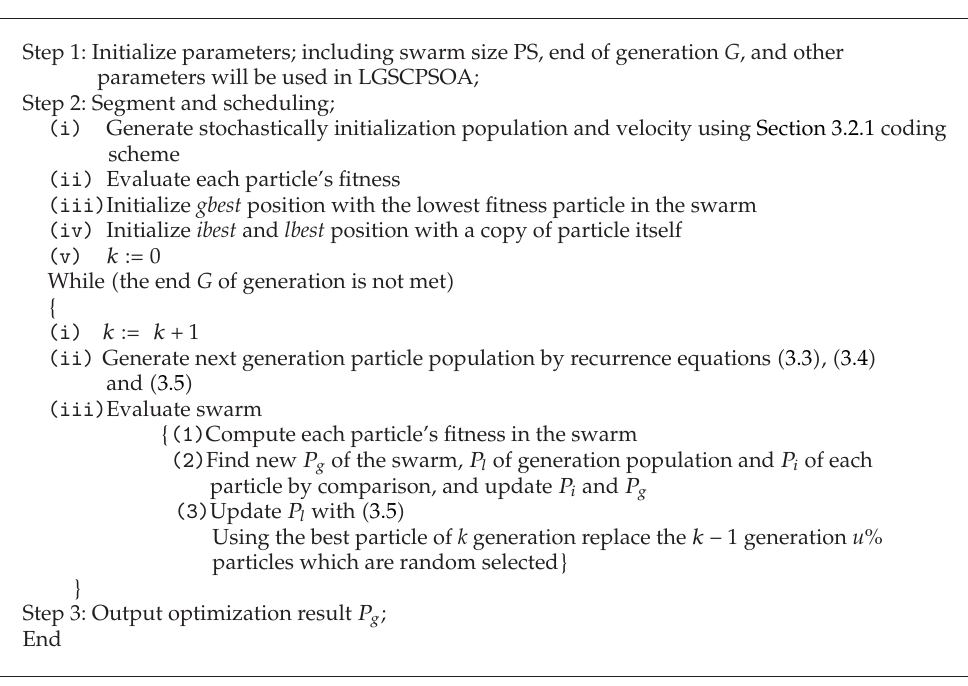
Algorithm 1: Pseudo Code of